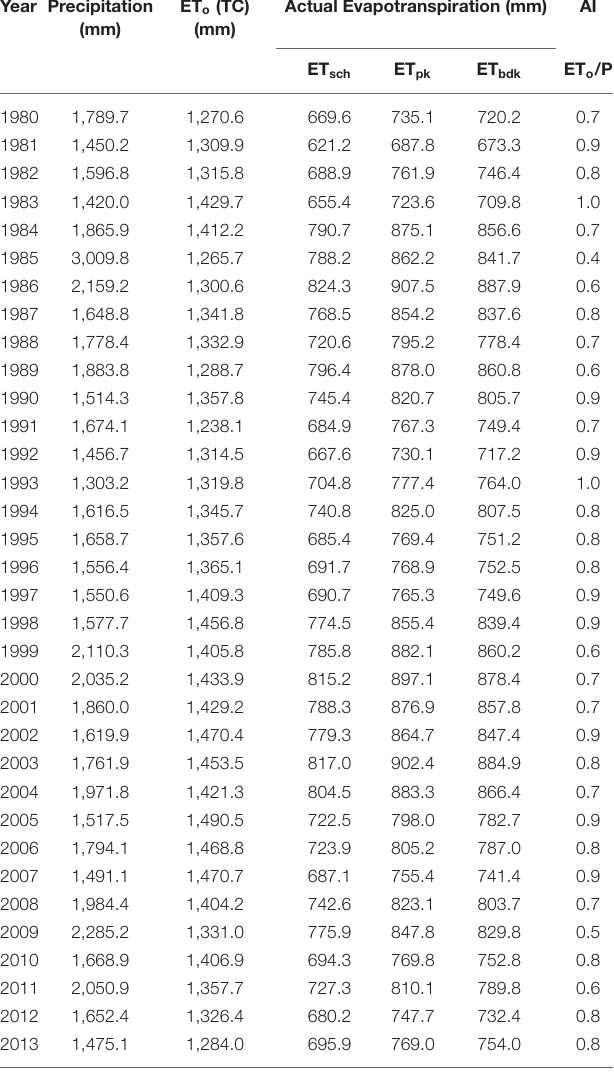
TABLE 3 | Annual observed and calculated data for the IRW in the 1980–2013 period. Year Precipitation (mm)